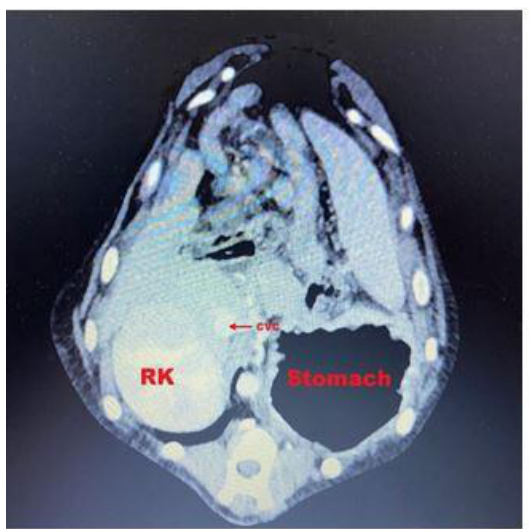
Fig.3: Contrast-enhanced computed tomographic images of the liver obtained during the portal phase (RK=Right Kidney, CVC= Cranial Vena Cava